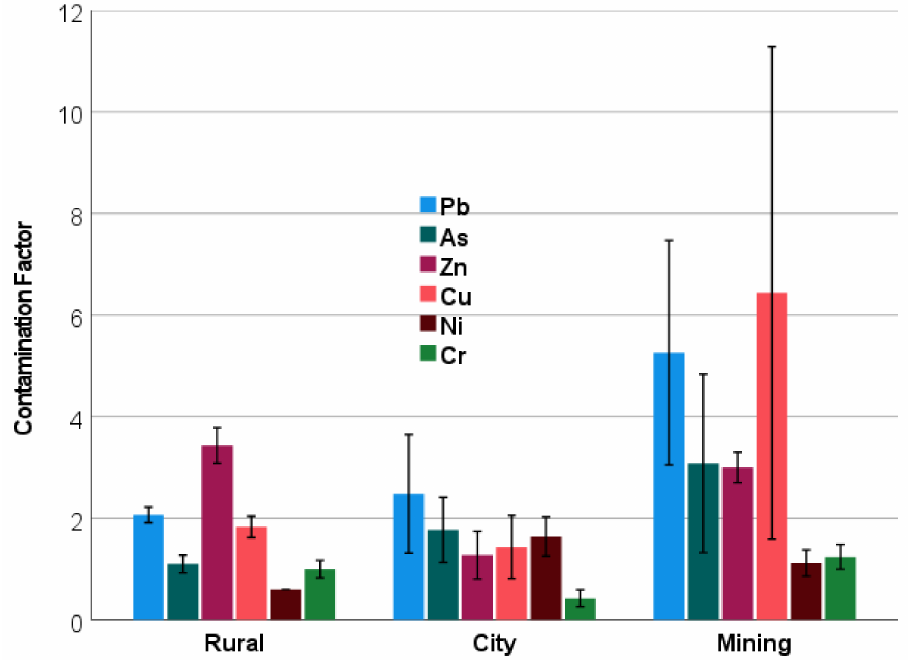
Figure 2. Mean contamination factors with standard deviation in the three types of urban